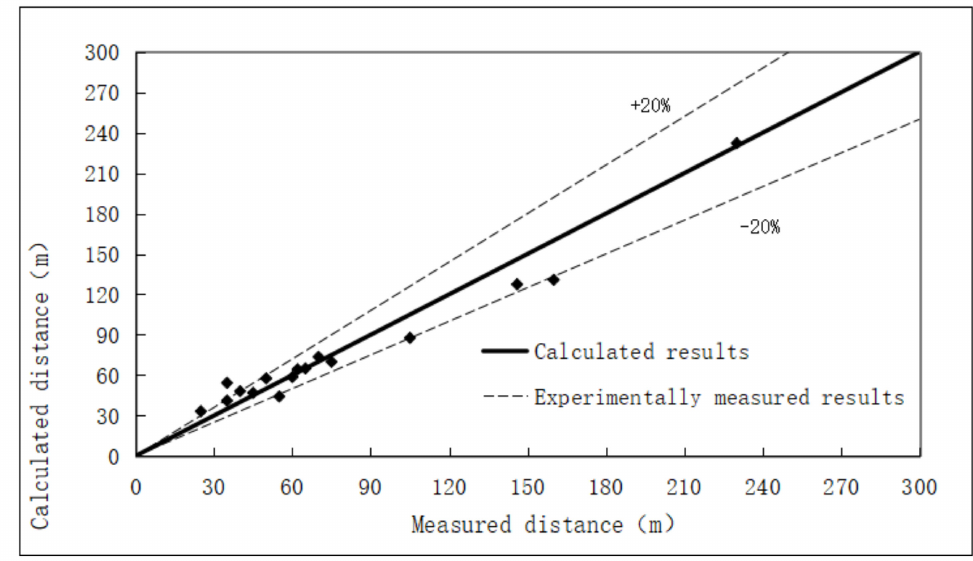
Figure 10. Comparison between calculated values and measured values of the maximum scouring depth of submerged spur dike